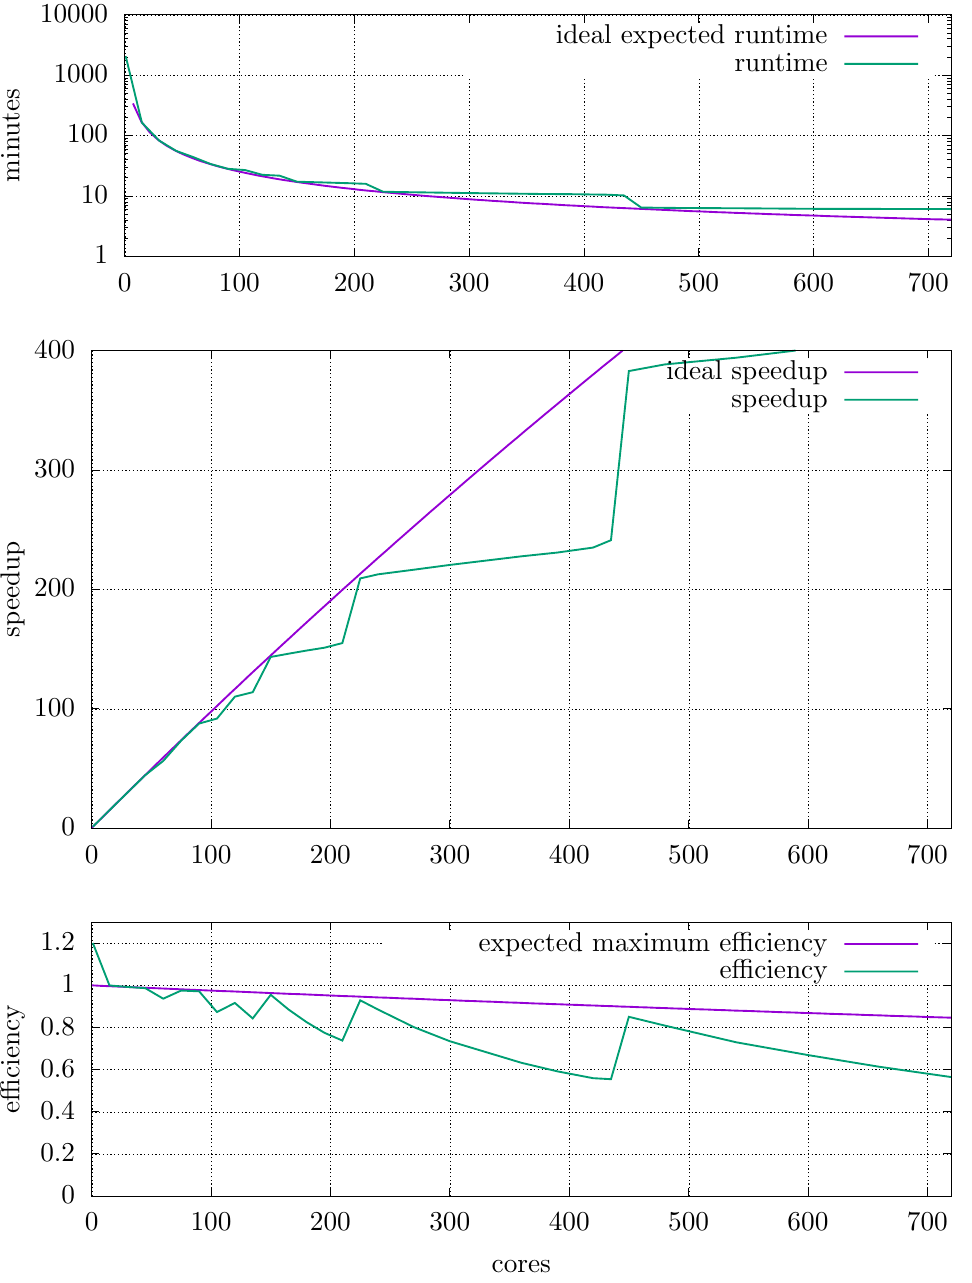
Figure 6 . Running time, relative speedup and e(cid:14)ciency graphs for cut f 1 ; 3 ; 4 ; 5 g .